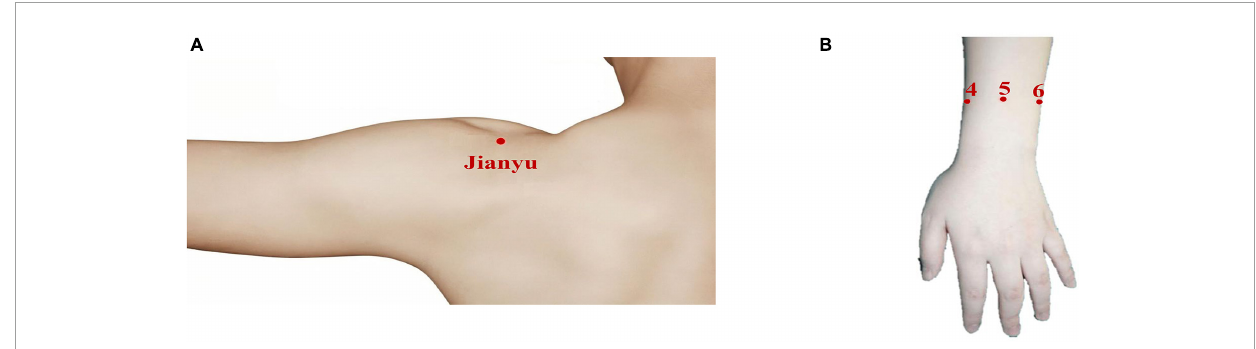
FIGURE1 Schematic diagram of the positions of the experimental devices. (A) The pressure pain model—point Jianyu. Point Jianyu is situated on the front side of the shoulder blade, in the dip between the shoulder blade and the large protrusion of the arm bone (Tao et al., 2005). (B) The treatment site—the upper 5 area of the wrist. 4, 5, and 6 correspond to the upper 4 area, the upper 5 area, and the upper 6 area, respectively. The upper 5 area is located in the middle of the palm surface between the two most prominent long palmar tendons and the radial carpal flexor